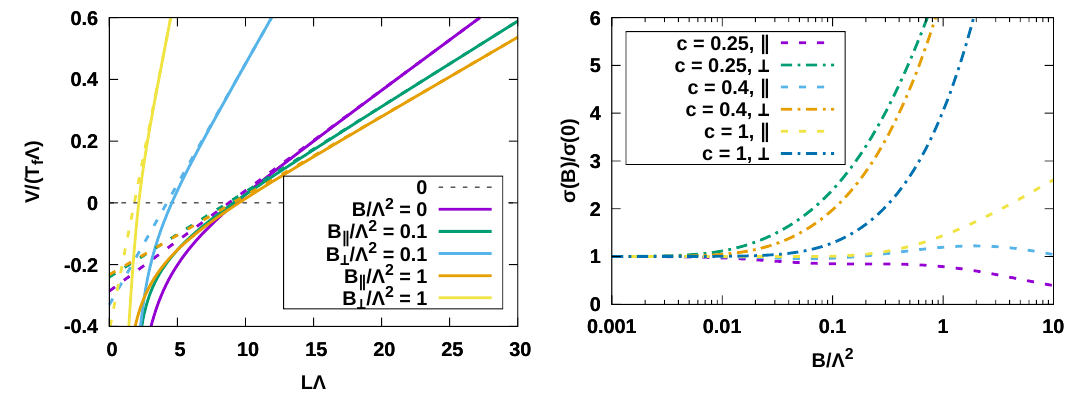
Figure 4 . Quark-antiquark potentials and string tensions for a = 0 . The plots present two cases, corresponding to the q ¯ q pair separated along the direction of the magnetic field ( B ) or one of the k directions orthogonal to it ( B ), all in units of Λ ∼ 1 GeV. The potentials themselves (left panel) ⊥ are shown together with the asymptotic behavior of the potentials for large separation (shown dashed). The string tensions (right panel) represent the slope of the potentials in the confining regime. For these plots we varied the parameter c introduced in (2.8), which controls the region of intermediate energy scales. The c = 0 . 25 case displays both IMC and agrees qualitatively with the results of [66], in the range of magnetic fields considered there eB ∼ 0 − 1 . 2